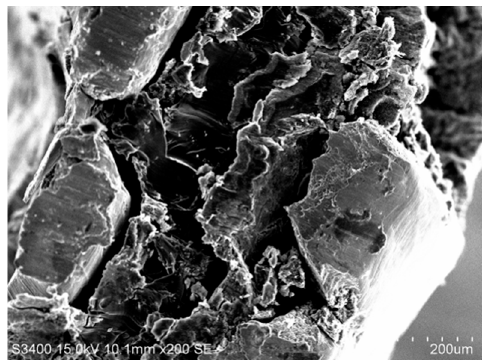
Figure 7. SEM analysis of the cross-section of titanium mesh-based MEA.